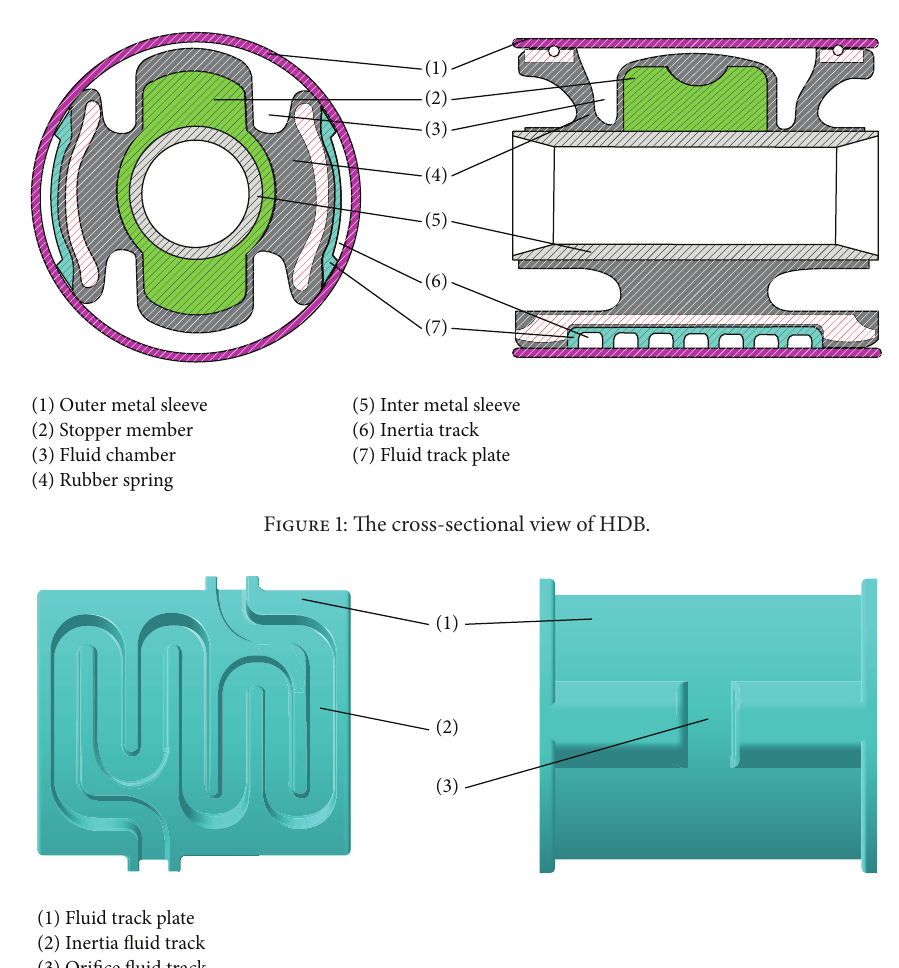
Figure 2: The fluid track plate of hydraulic